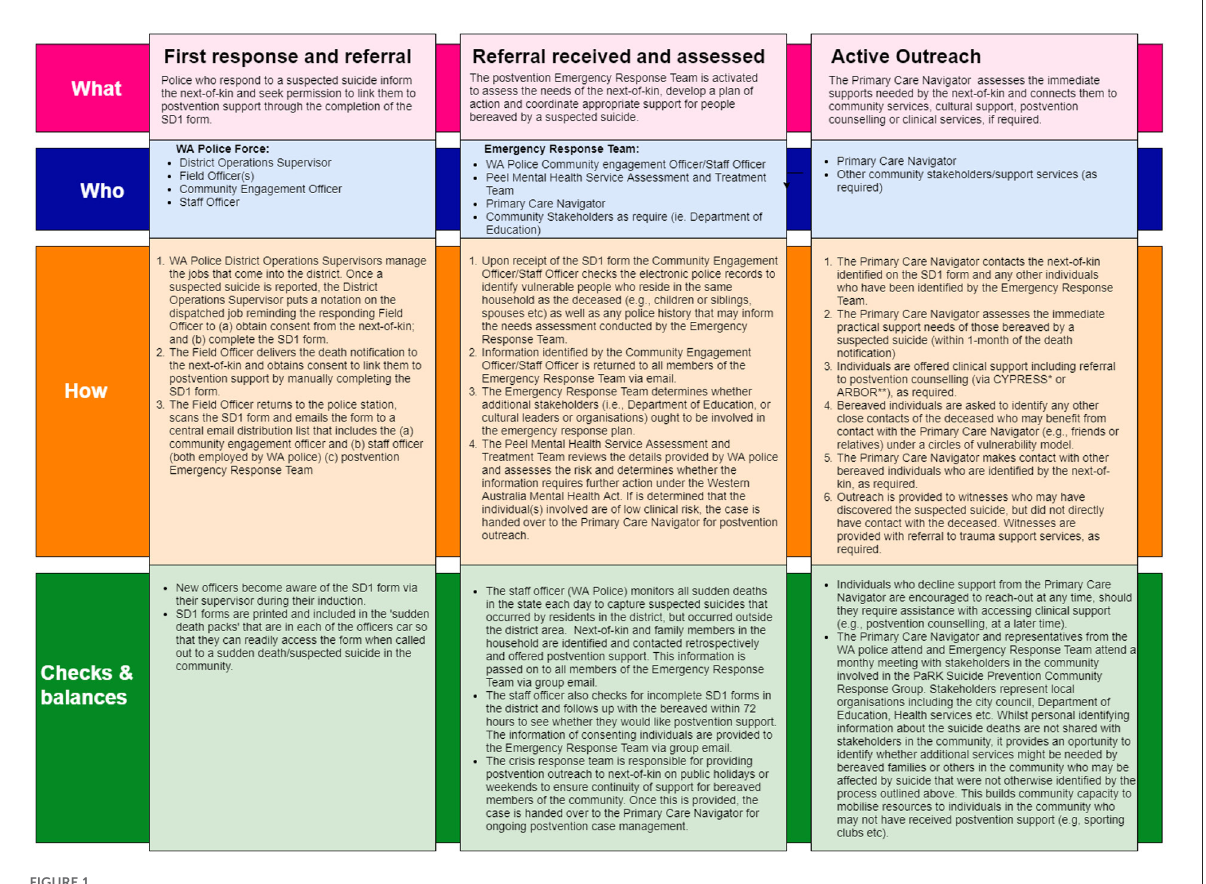
FIGURE1 Operational description of the primary care navigator (PCN)